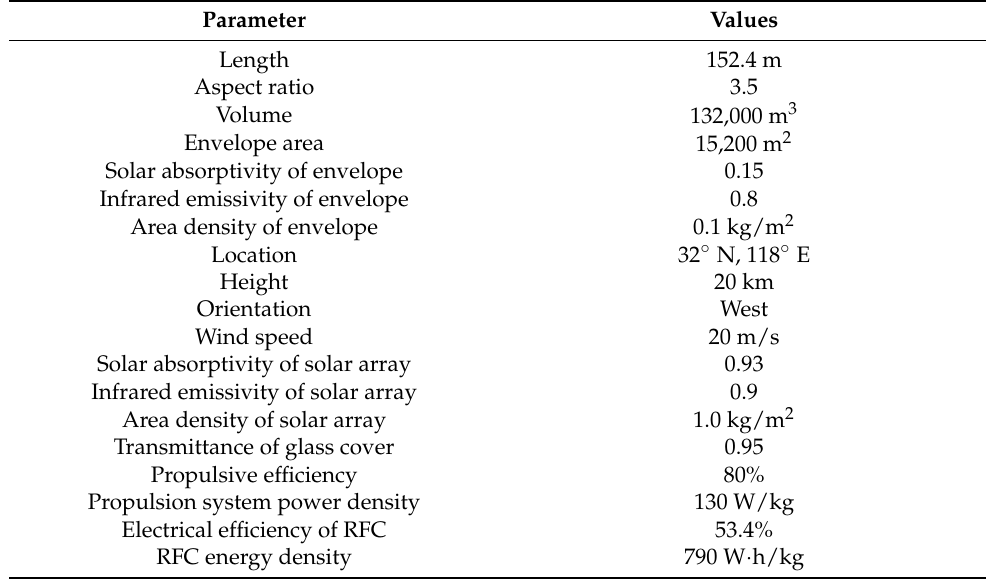
Table 1. Design parameters of the